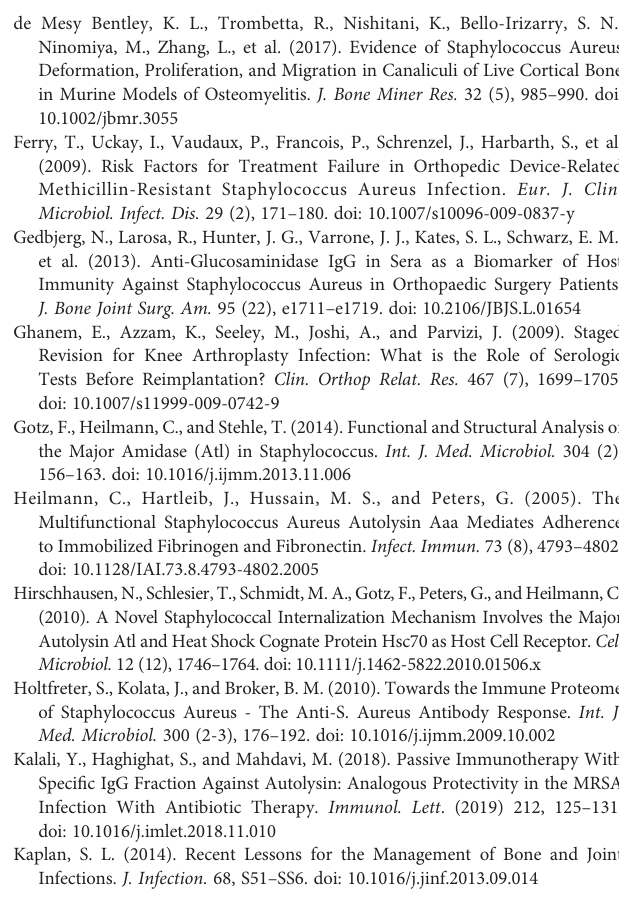
Supplementary Figure S1 | Quality controls of puri fi ed TPH-101 anti-Gmd mAb. ExpiCHO cells were transiently transfected with TPH-101 heavy and light chain genes, and the secreted mAb was puri fi ed from culture supernatant via protein-A af fi nity chromatography as previously described (Brannan et al., 2019). The total yield of TPH-101 mAb was 400 ug/ml, and the purity was determined to be >99% via Coomassie-stained denatured SDS-PAGE and SEC-HPLC chromatograph. No degradation of the mAb was observed. The speci fi city of TPH-101 binding to Gmd was con fi rmed via western blot of total S. aureus USA300 protein extract as previously described (Varrone et al., 2014). Supplementary Figure S2 | Lack of correlation between anti-Gmd antibody physical IgG titer and Gmd neutralizing activity in human sera. A linear regression analysis of anti-Gmd physical IgG titer determined by Luminex vs. Gmd neutralizing activitydetermined by M. luteus cellwall digestion was performed onthe fi ve patient sera that contained Gmd neutralizing activity described in Table 1 . No signi fi cant association was found by the Spearman ’ s rank correlation coef fi cient. Supplementary Figure S3 | Gmd protein isspeci fi cally detected byTPH-101 antibodyinWesternBlotassay.100and50ngofrecombinantGmdproteinwasheated at70°Cfor10minandseparated via SDS-PAGE.Gelincubatedwith1µg/mlanti-THP 101(lot#2378-1A-02)for2hranddetectedby1:3000dilutionofKPLGoatanti-Human HRP (KPL#474-1006; lot#150100) for 1 hrusing